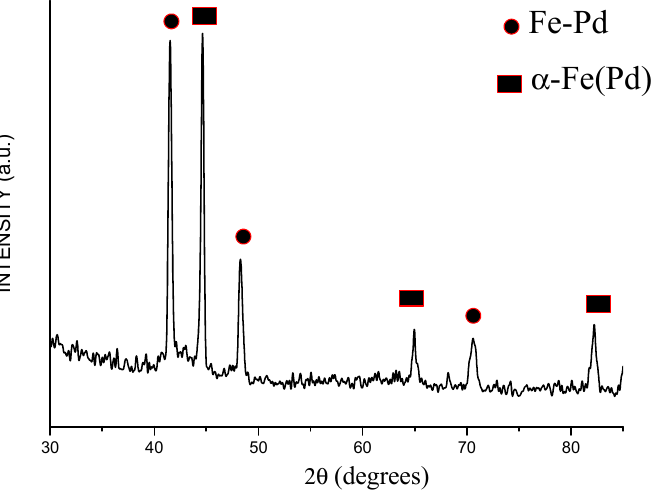
Figure 11. XRD pattern of the powder alloy obtained by annealing of the Fe@Pd core–shell particles (Fe-Pd is a Fe-rich solid solution).